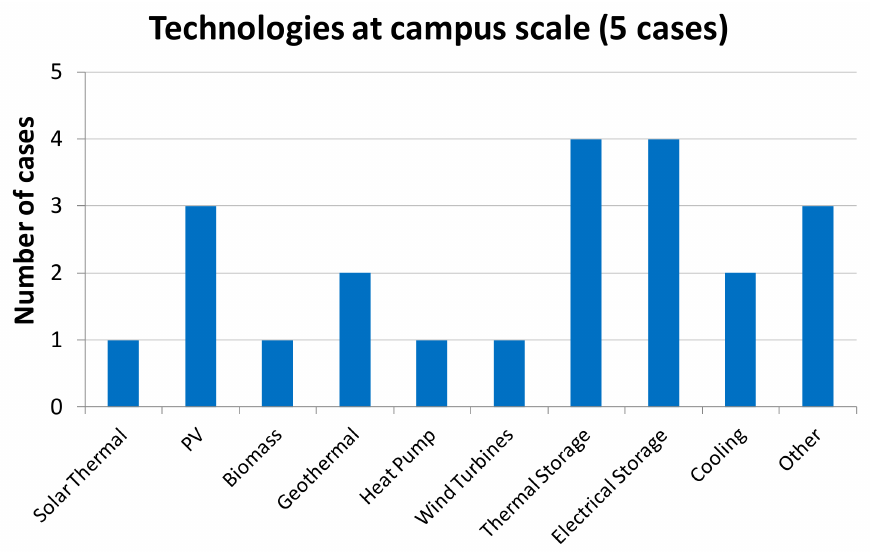
Figure 14. Histogram of occurrence obtained for the technologies installed at the campus